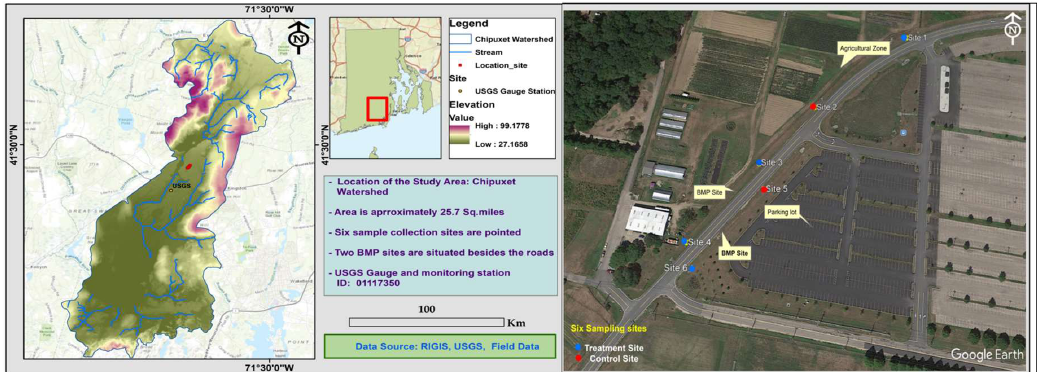
Figure 2. The map illustrates the location of the study area in Rhode Island, USA. Red bounding box shows the exact location of the study site shown above (Google Earth screenshot- on the right).